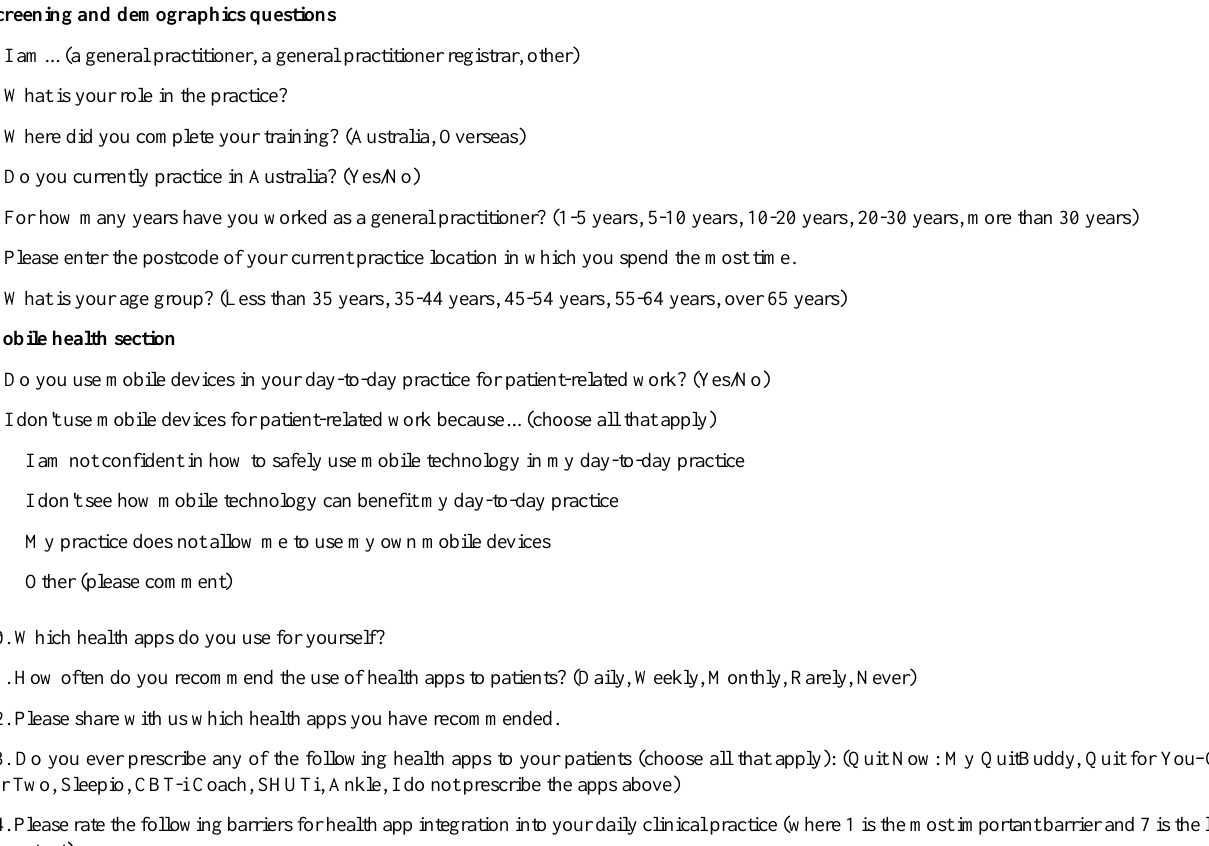
Textbox 1. Survey questions analyzed as part of this